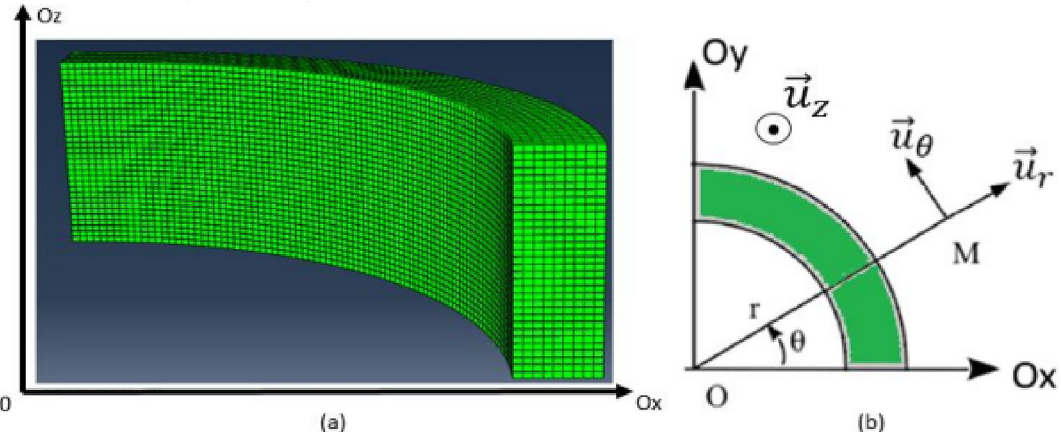
Figure 7. Coordinated system used cutting view ( a ) and top view ( b ) of the laminated magnetic